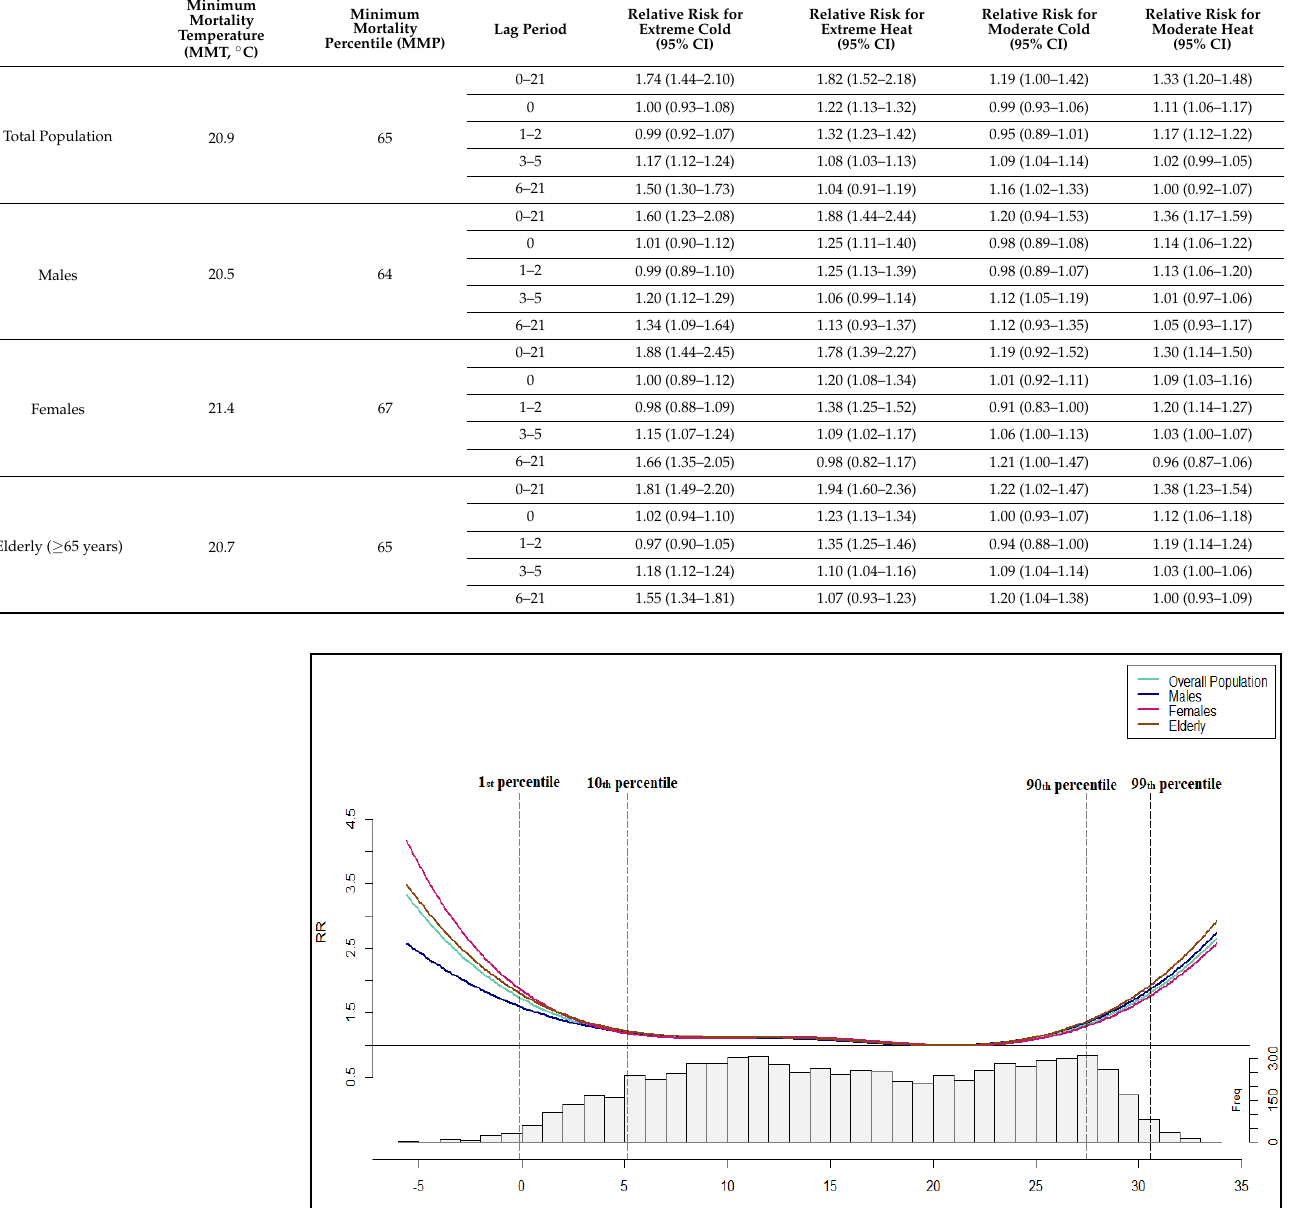
Table 2. MMT and cumulative relative risks of cardiorespiratory mortality under various lag intervals, considering constant exposure, for the total population and its subgroups in EMT between 1999 and 2018.